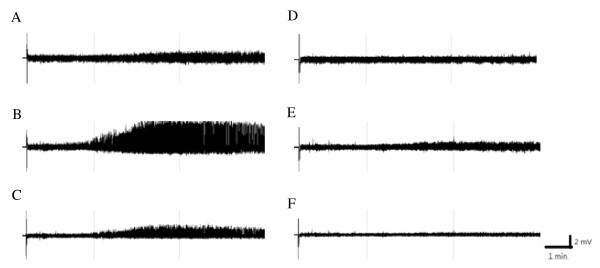
The focal epilepsy induced by microinjection of pilocarpine into the CeA. Panels A, B, C, D, E and F represent the EEG signals acquired from the electrodes of left frontal, left parietal, left occipital, right frontal, right parietal and right occipital cortices, respectively. The epileptiform EEGs were predominantly recorded from the electrode of left parietal cortex.